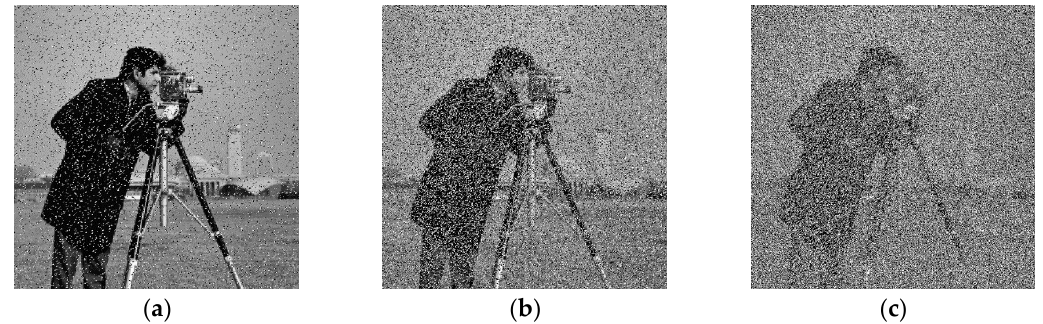
Figure 9. The decrypted results of the encrypted image with different pixels occlusion: ( a ) 4 × 4, ( b ) 6 × 6, ( c ) 8 × 8.